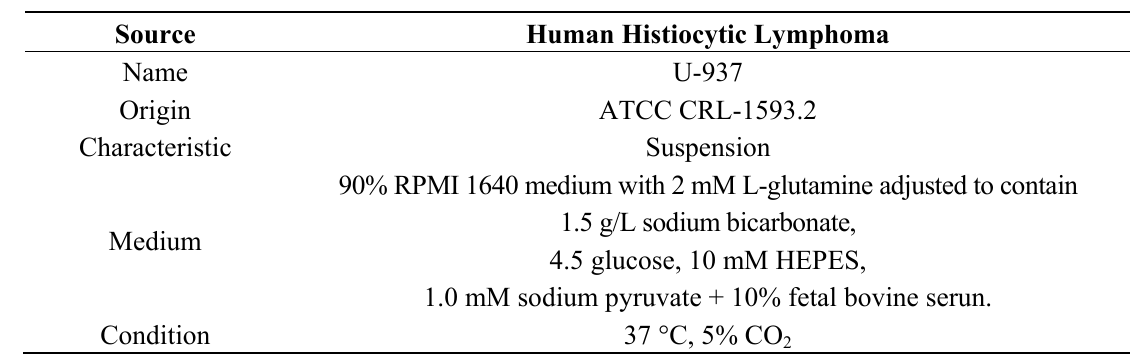
Table 1. Cell information